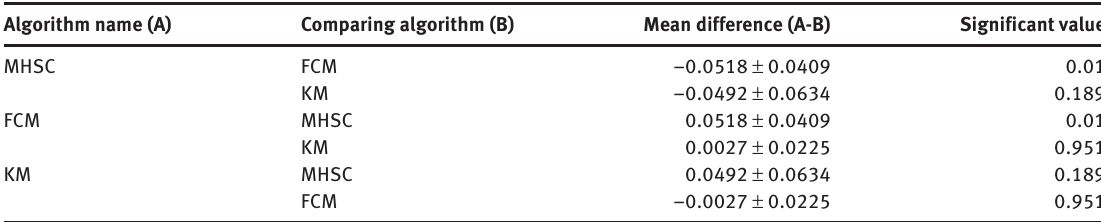
Table 8: Estimated Means and Pairwise Comparisons of Different Algorithms on the Minkowski Score Obtained by ANOVA Testing for the Glass Dataset.